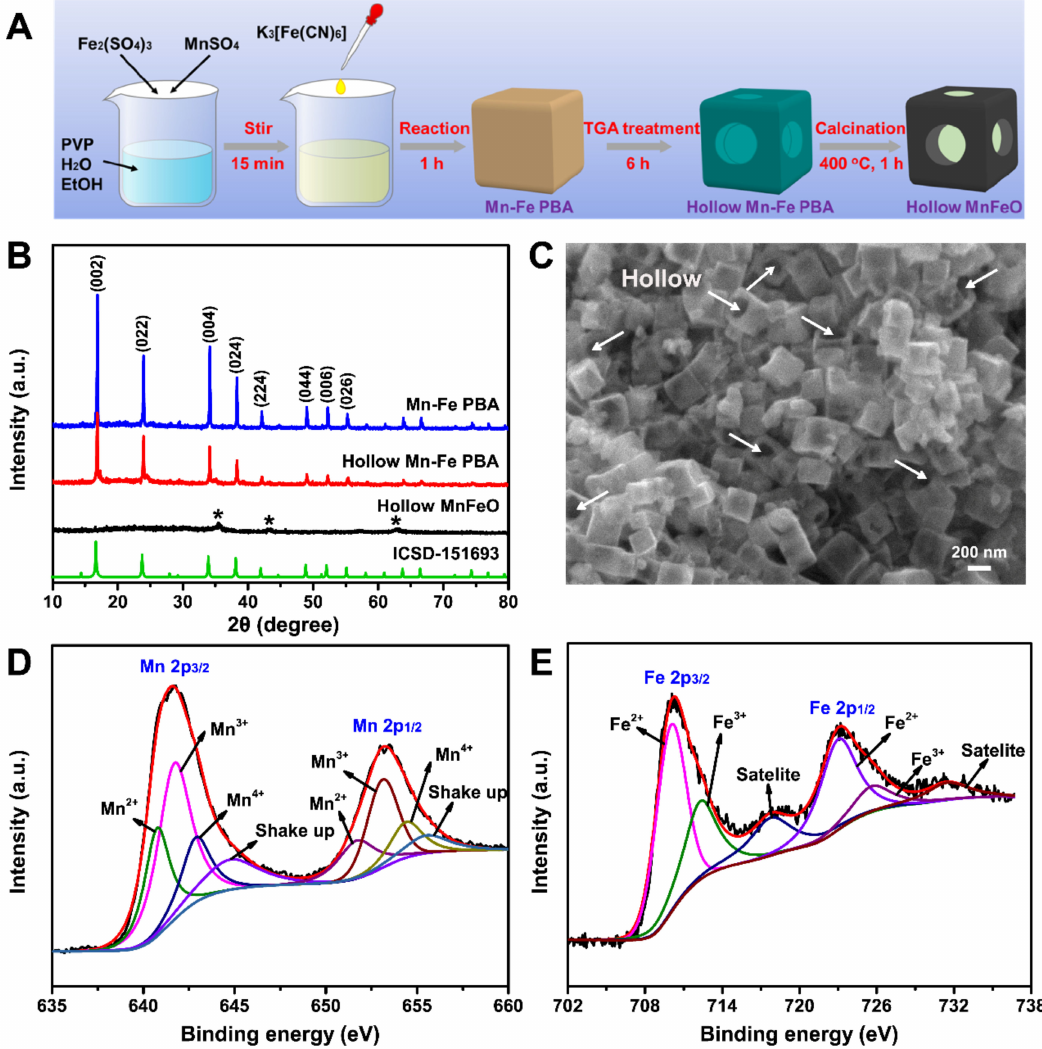
Figure 1. ( A ) illustrates the preparation process of hollow MnFeO. ( B ) compares XRD profiles of different materials. ( C ) depicts the SEM image of hollow MnFeO. ( D , E ) present fine Mn 2p and Fe 2p XPS of hollow MnFeO,